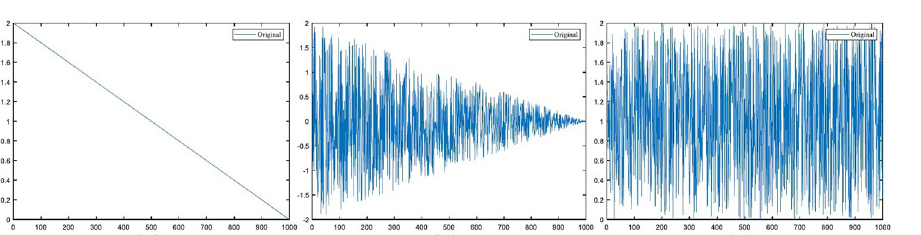
! -value under 1000 iterations.